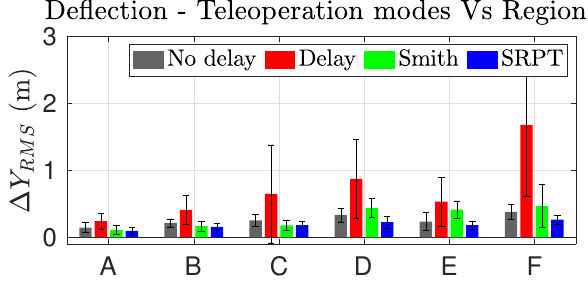
Figure 15. Lateral deviation in regions vs.